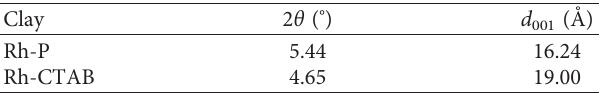
Table 1: Basal distance of the diffraction peak (001) of the Rh-P and